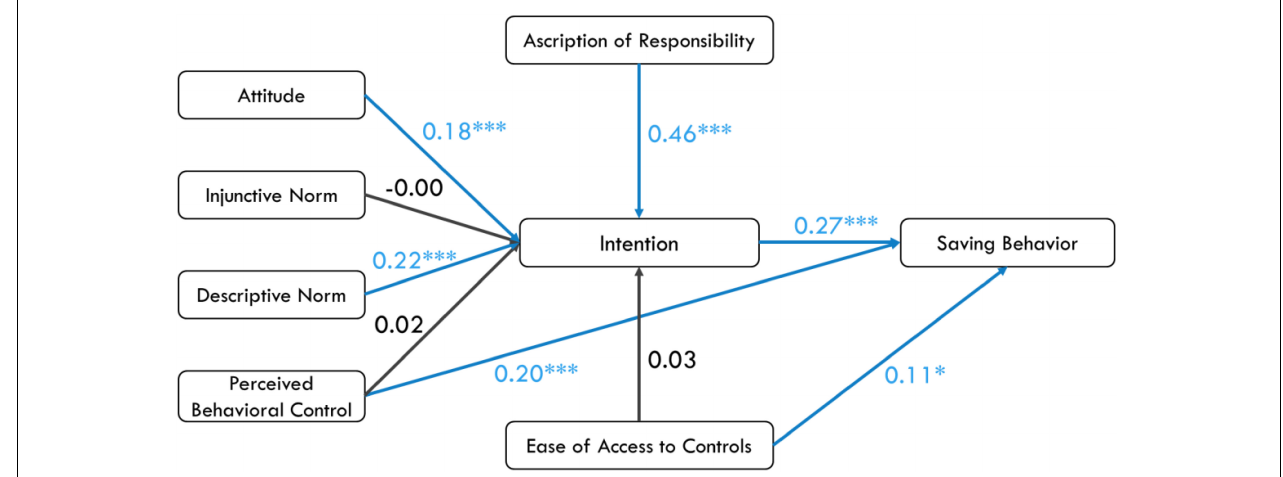
FIGURE 4 | Result of path modeling on the extended TPB model for shared offices. ∗ p < 0.05; ∗∗ p < 0.01; ∗∗∗ p < 0.001.